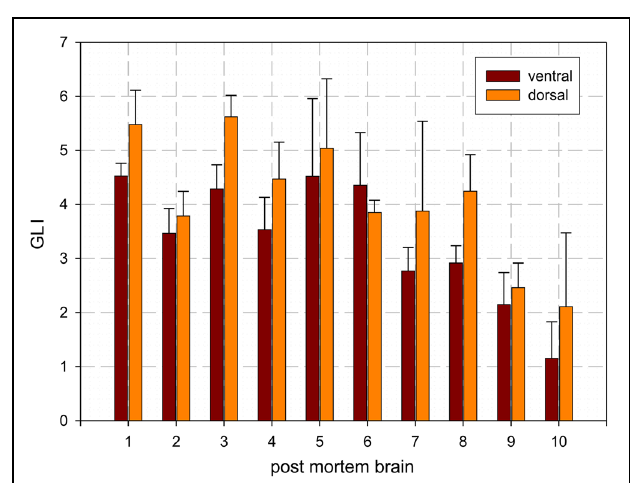
FIGURE 3 | Mean values and SD of cell density distribution of the ventral and dorsal dentate nucleus as estimated by the Grey